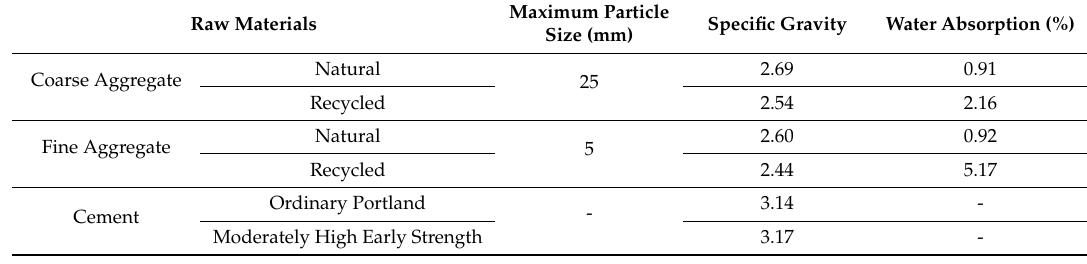
Table 1. Physical characteristics of the aggregates used in the experiment. Table 2. Mixture proportions (all quantities in kg/m 3 unless specified otherwise).